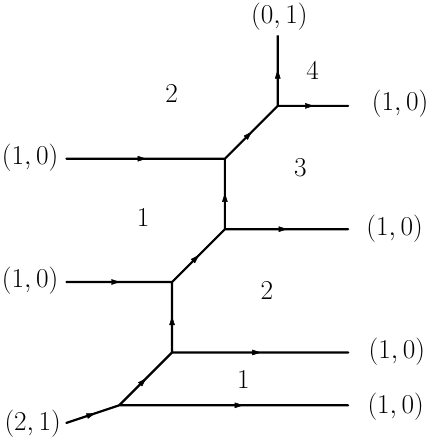
Figure 12. Con(cid:12)guration corresponding to U(4 j 2) (cid:9) Kac-Moody